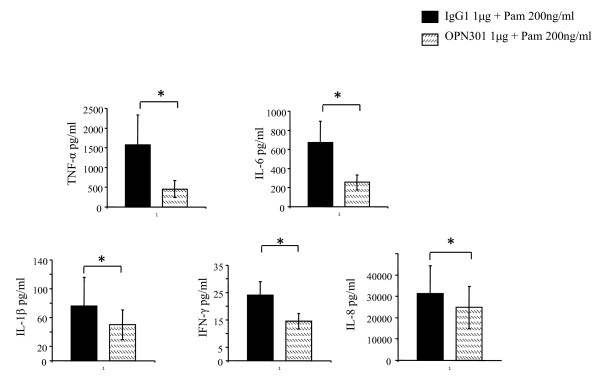
OPN301 significantly inhibited cytokine production in SFMC compared to IgG isotype control. RA SFMCs (n = 6) were stimulated with Pam3CSK4 in the presence or absence of OPN301 (1 μg/ml) or matched IgG isotype control for six hours. Values are expressed as the mean ± SEM. * P < 0.05, significantly different from control as determined using Wilcoxon Signed Rank analysis.